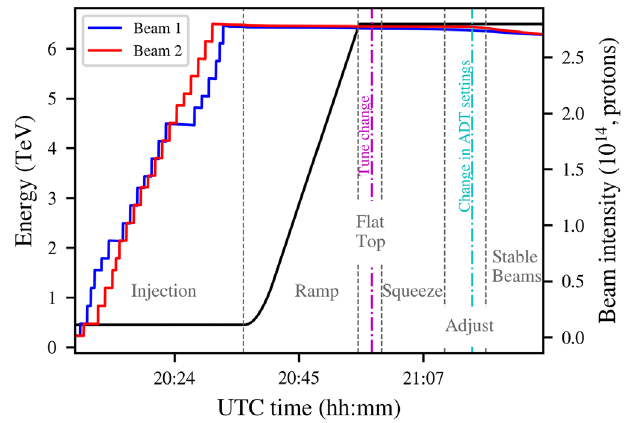
FIG. 1. The LHC operational cycle in 2018 (Fill 7333). The intensity evolution of Beam 1 (blue) and 2 (red) and the beam energy (black) are illustrated. The vertical gray lines denote the beam modes and important modifications during the cycle such as the change of tune (magenta) and the modification in the transverse damper ’ s settings